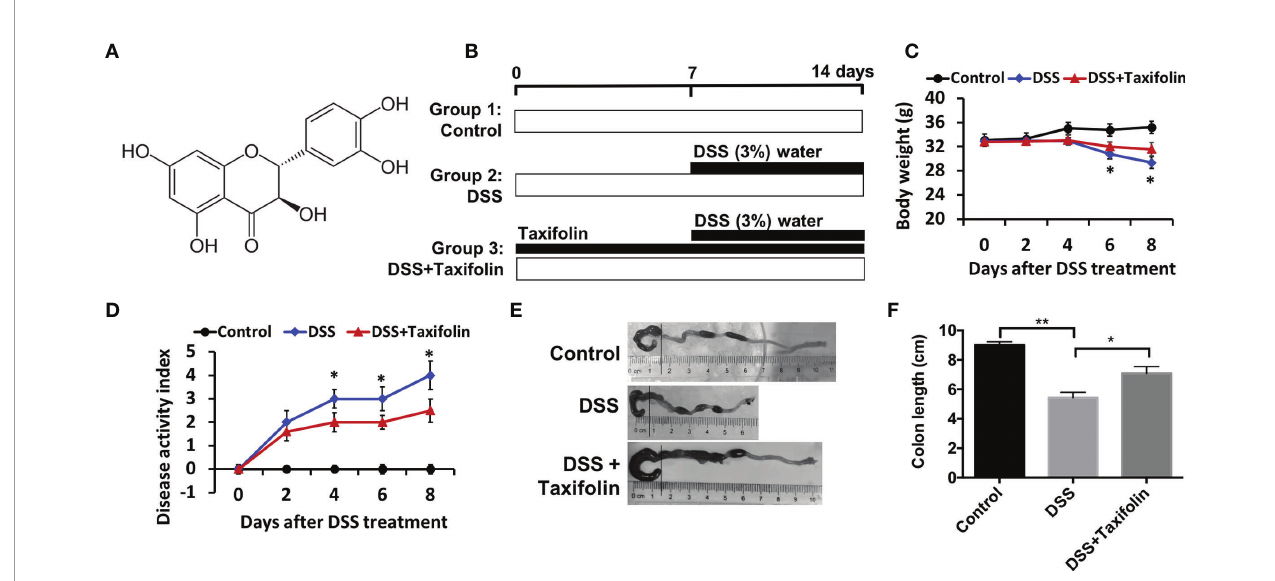
FIGURE 1 | Oral administration of taxifolin alleviated DSS-induced acute colitis symptoms of mice. (A) Chemical structure of taxifolin; (B) A timeline of the experiment treatment; (C) Body weight loss; (D) Disease activity index score; (E , F) Colon length of the mice. Data were expressed as means ± SEM ( n = 10). * P < 0.05; ** P <